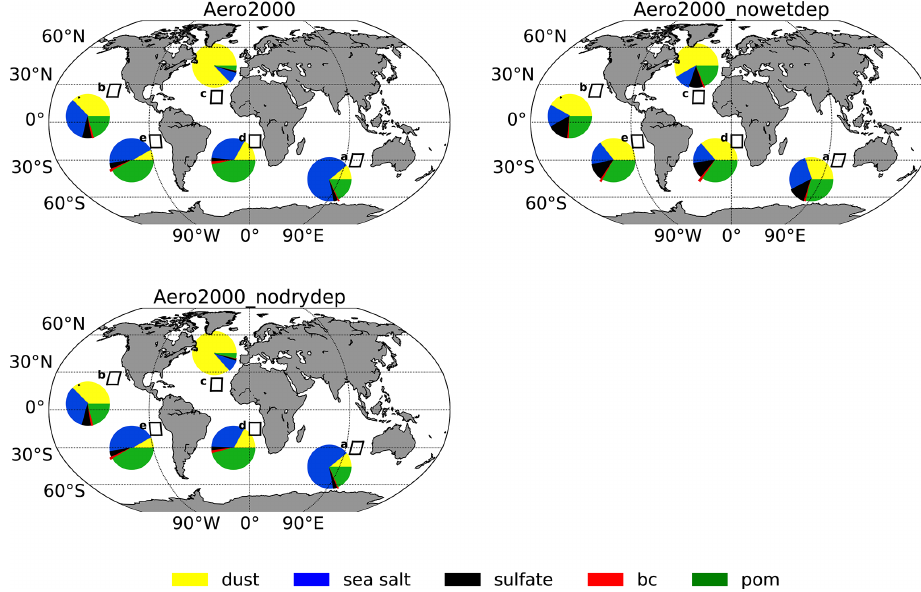
Figure 7. The relative columnar burden contribution of each aerosol type to the total column burden in the simulations Aero2000, Aero2000_nodrydep, and Aero2000_nowetdep in five regions of marine stratocumulus clouds. The boxes indicate the five regions of stra- tocumulus clouds – a: Australian, b: Californian, c: Canarian, d: Namibian, e: Peruvian.